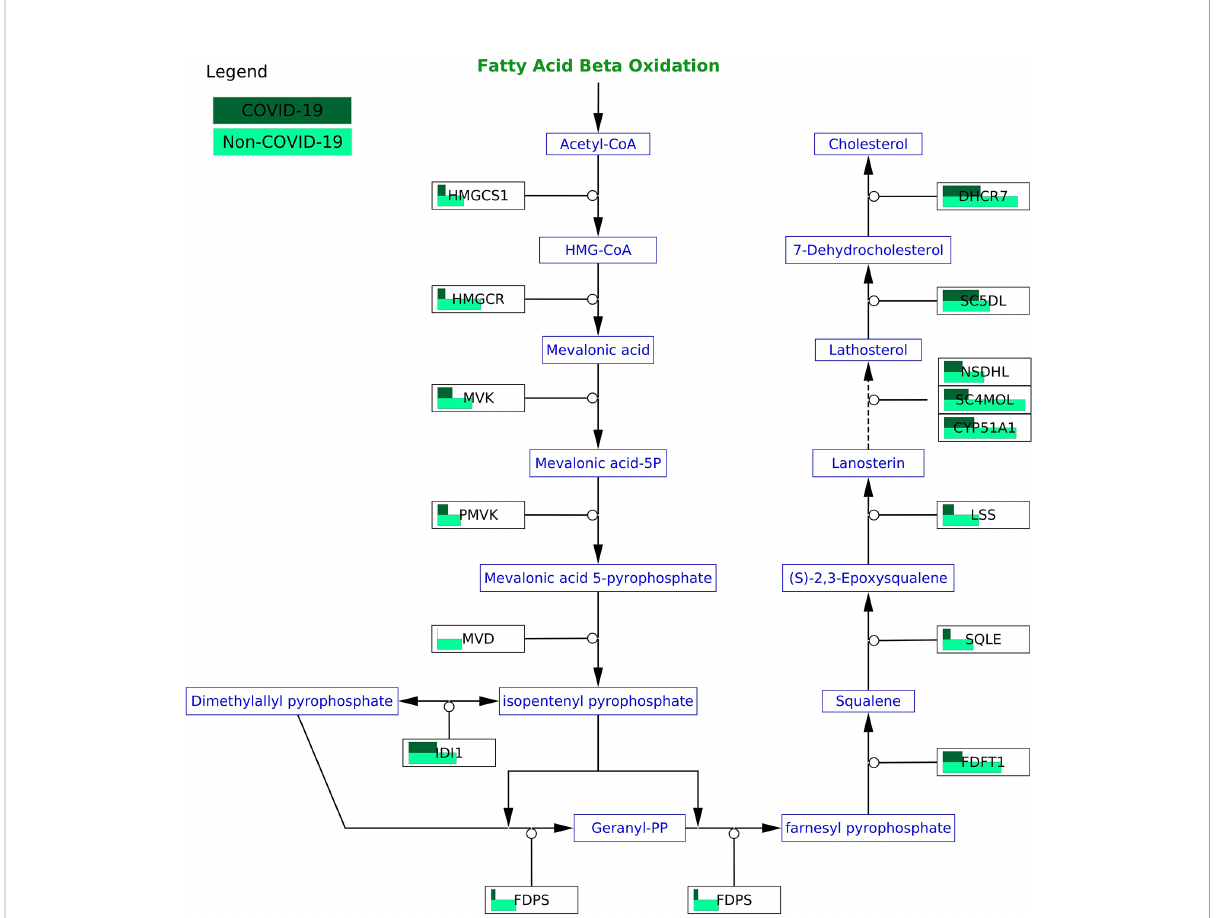
FIGURE 6 COVID-19 protein expression visualized in the cholesterol biosynthesis pathway (WP197) in the testis. All proteins in the pathway are less abundant in COVID-19